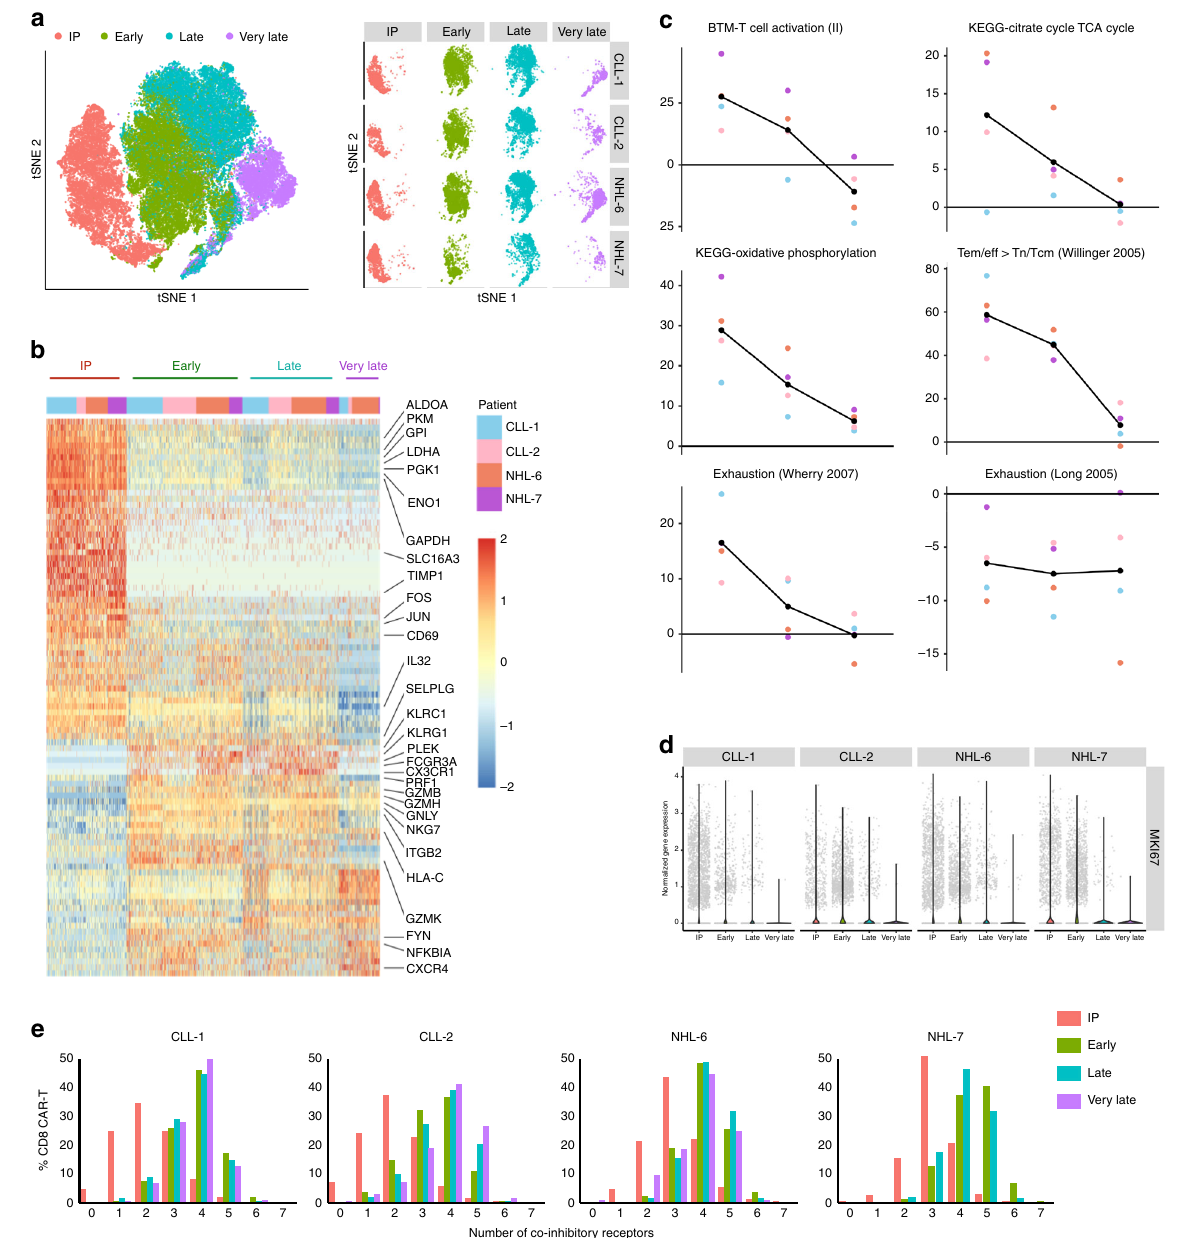
Fig. 5 Single-cell transcriptome of infused CAR-T cells are distinct from CAR-T cells in blood. a Left, t-SNE representation of 62,167 CD8 + CAR-T cells concatenated from the IP, early, late, and very late time points of four additional patients. Single cells from the early time point are overlaid on single cells at the late time point. Right, t-SNE analysis of concatenated CD8 + CAR-T cells from each time point in each patient. b Heatmap displaying the expression of genes that are differentially expressed between each time point with selected genes highlighted. Only genes that were differentially expressed between time points in all four patients are represented in the heatmap (FDR = 0.05, log2FC = 1.5). Color scale represents gene expression levels as a z -score. c GSEA using indicated gene sets was performed on CD8 + CAR-T cells isolated from the IP and blood at distinct time points after adoptive transfer. A combined Z -score was calculated for pairwise comparisons between CD8 + CAR-T cells from each post-infusion sample relative to the IP. A negative Z - score represents higher expression of the gene set in CD8 + CAR-T cells from the IP. Each point represents an individual patient. FDR = 0.01, absolute continuous Z -score > log2(1.5), absolute discrete Z -score> log2(1.5). d Violin plot of MKi67 gene expression at the IP, early, late, and very late time points. e Co-expression of zero to seven inhibitory markers, including PD-1, LAG-3, TIM-3, KLRG1, TIGIT, 2B4, and CD160 on CD8 + CAR-T cells from the IP and isolated at the early, late, and very late time points after infusion. Source data underlying Fig. 5e is provided as a Source Data fi le. determined the distribution of IRF and DRF clones among the high levels of genes associated with cytotoxicity and proliferation, four transcriptionally distinct clusters in the IP. Both IRF and respectively ( Fig. 7c), despite the fi nding that these clusters only DRF clones were present in all four clusters (Fig. 7c). However, a comprised 42.7% and 27.1% of cells in the IP in NHL-6 and majority of the IRF clones in both patients were detected in NHL-7 (Fig. 6b), respectively. In contrast, clusters 1 and 3 clusters 2 and 4 (NHL-6: 85.6%, NHL-7: 84.6%), which expressed harbored few IRF clones. NATURE COMMUNICATIONS| (2020) 11:219